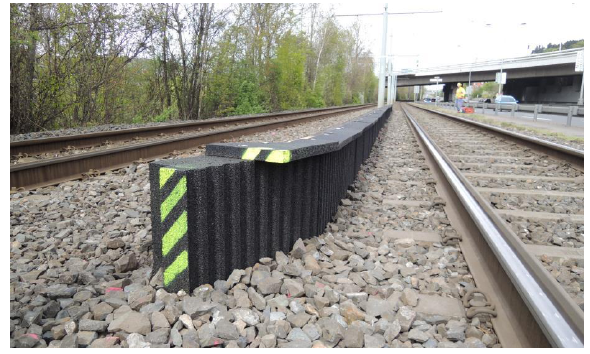
Figure 10. Municipal Noise-absorbing Screen after